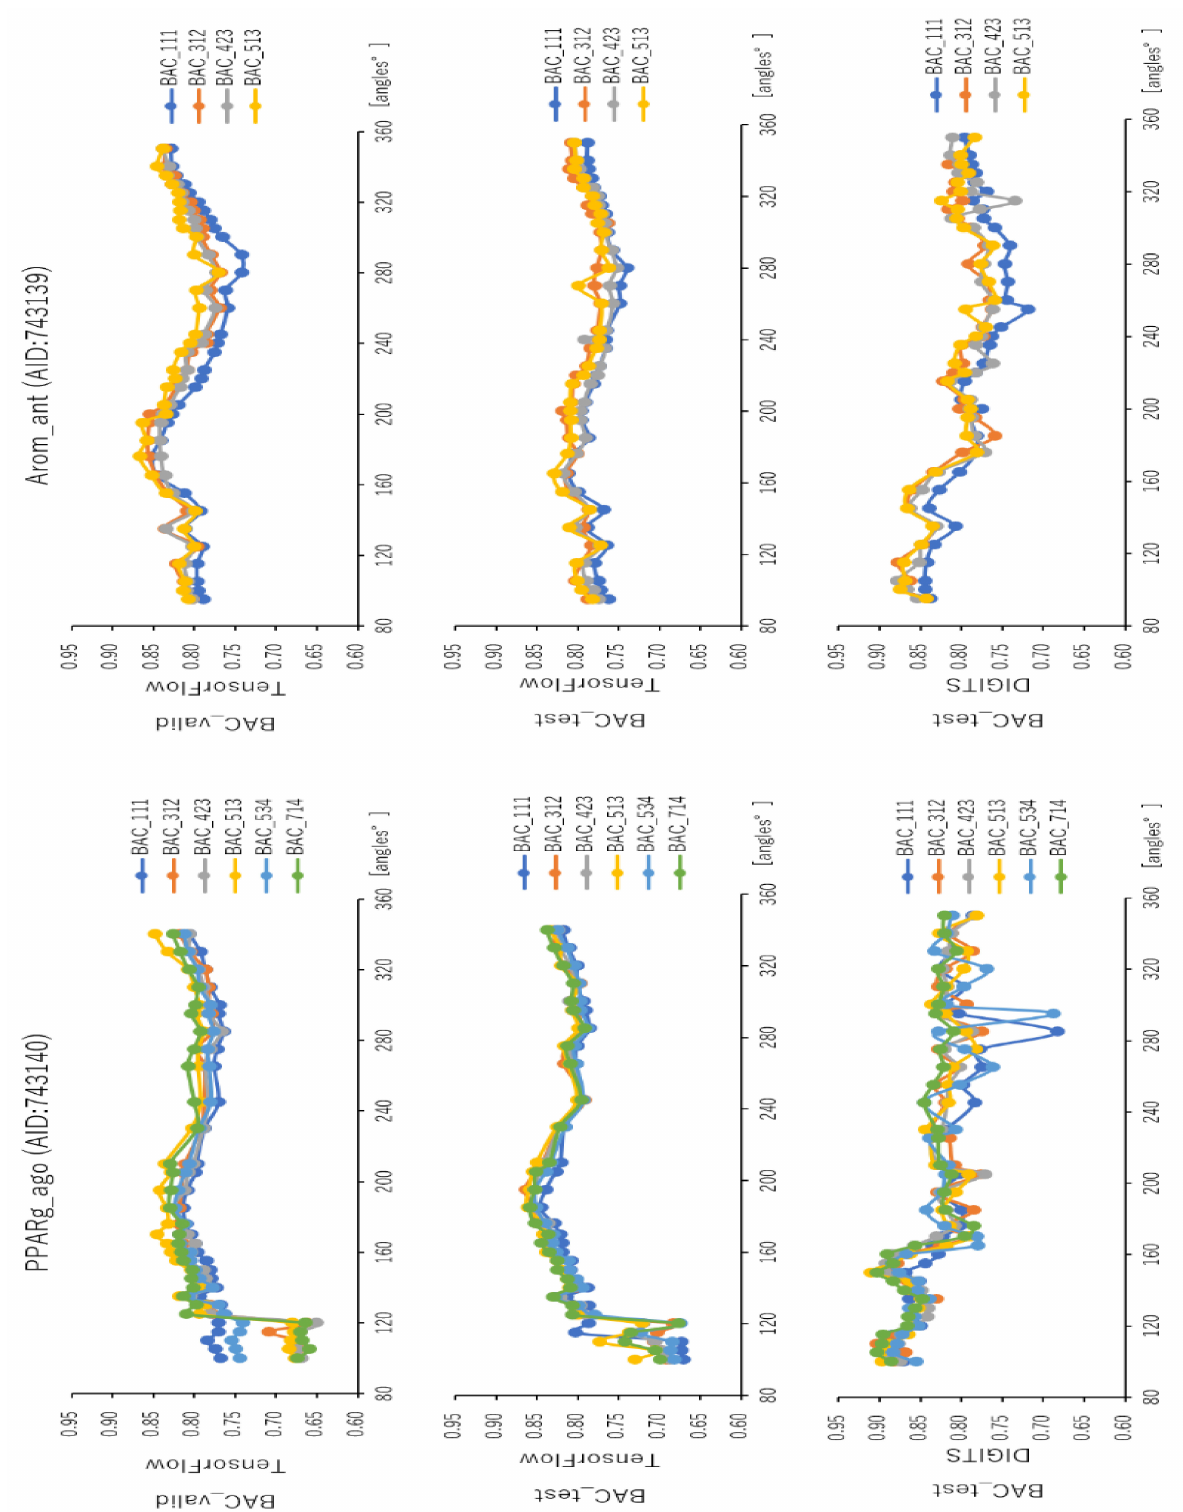
Figure 4. BAC for PPARg_ago (AID:743140) and Arom_ant (AID:743139) on the validation and test datasets using Ten- sorFlow and Keras on the test dataset using DIGITS with 31 angles in DeepSnap-DL. The different curves represent different ratios of the splits among the datasets, training:validation:test =1:1:1, 3:1:2, 4:2:3, 5:1:3, 5:3:4, and 7:1:4, respectively. Three-fold experiments were